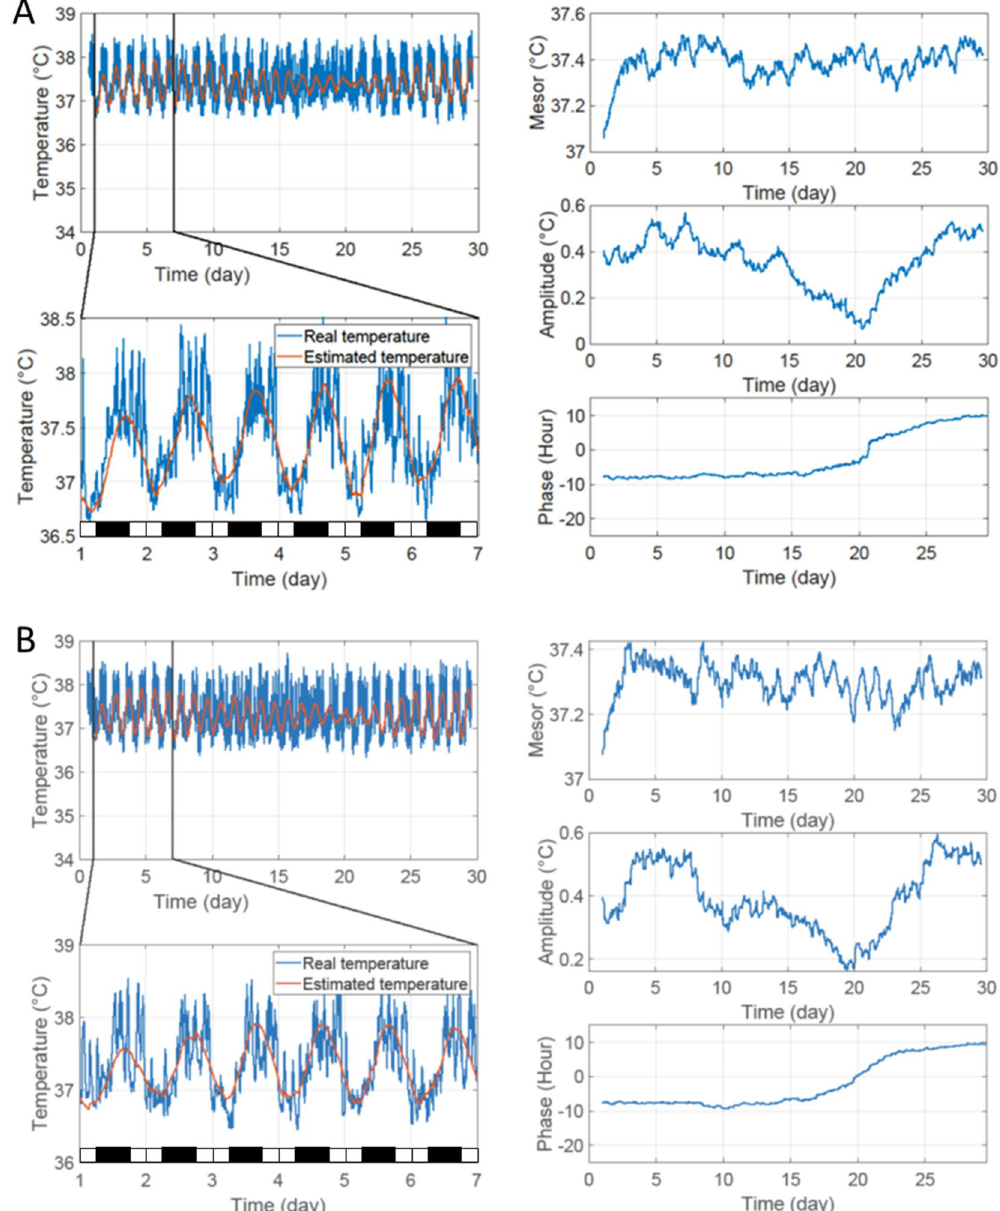
Figure 1. Resynchronization to a six-hour phase shift without 2 G stimulation (LD + 6 condition). Representative examples of a BVL ( A ) and a sham ( B ) rat in the LD + 6 condition. The blue line represents the recorded Tc. The orange line represents the estimated Tc from the extended COSINOR analysis. The left panels represent the entire recording of temperature (left upper panel) and a zoom on the first week of recording with estimated Tc (lower panel). The black and white bars in the left lower panel symbolize dark and light periods, respectively. The right panel (from top to bottom) represents the progressive modification of mesor (°C), amplitude (°C), and phase